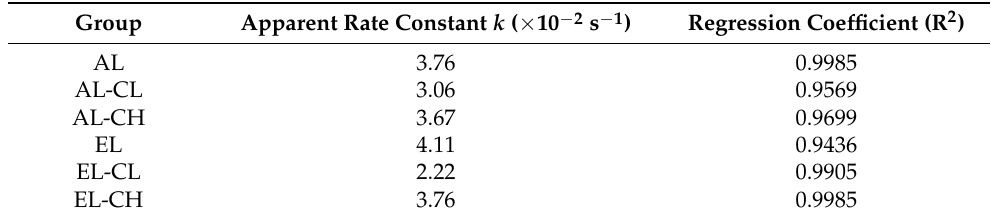
Table 1. Kinetics parameters of FFA release under stimulated adult and infant intestinal digestion in